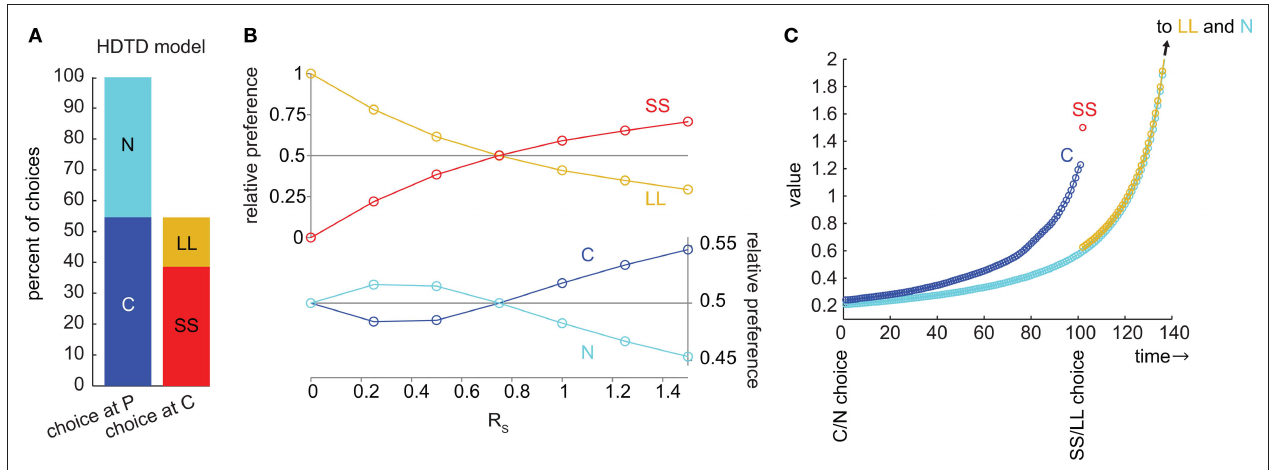
point as the preference for SS overtook LL, meaning that this model would not precommit to avoid an impulsive choice. (C) In the HDTD model, the undiscounted value of C is between the discounted values of SS and LL. However, the values of C and N never cross, so C is preferred to N whenever SS is preferred to